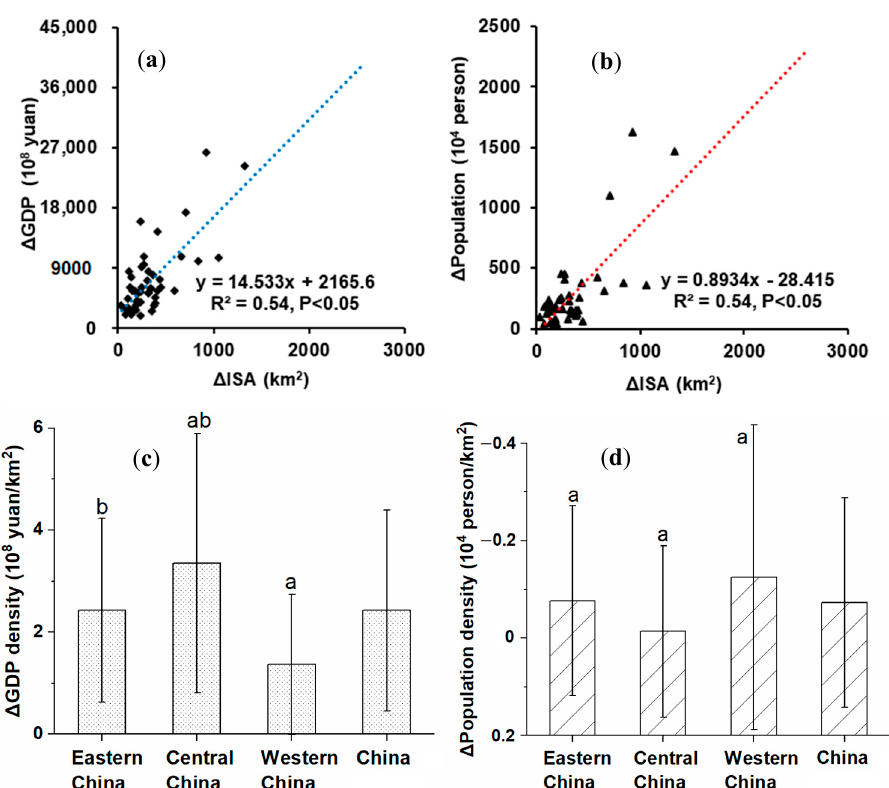
Figure 6. Socioeconomic factors related to ISA changes. ( a ) Correlation between GDP changes and ISA changes. ( b ) Correlation between population changes and ISA changes. ( c ) Changes in national and regional GDP densities. ( d ) Changes in national and regional population densities. The symbol Δ represents a change. The lowercase letters “a” and “b” above the bars in subfigures ( c , d ) represent significant differences at 5% level.